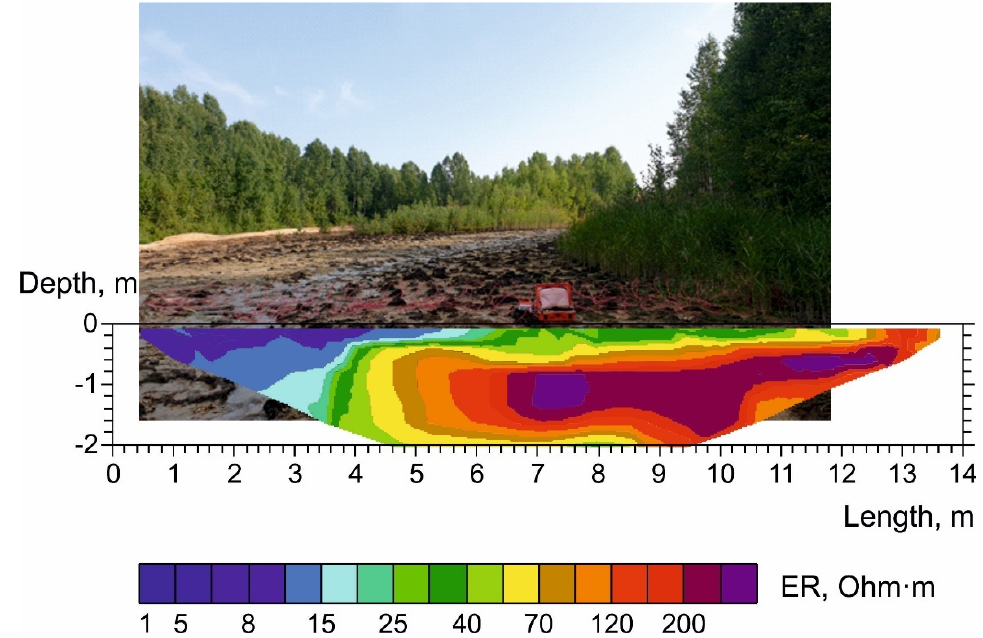
Figure 7. Geoelectric section along the profile of micro-ERT.